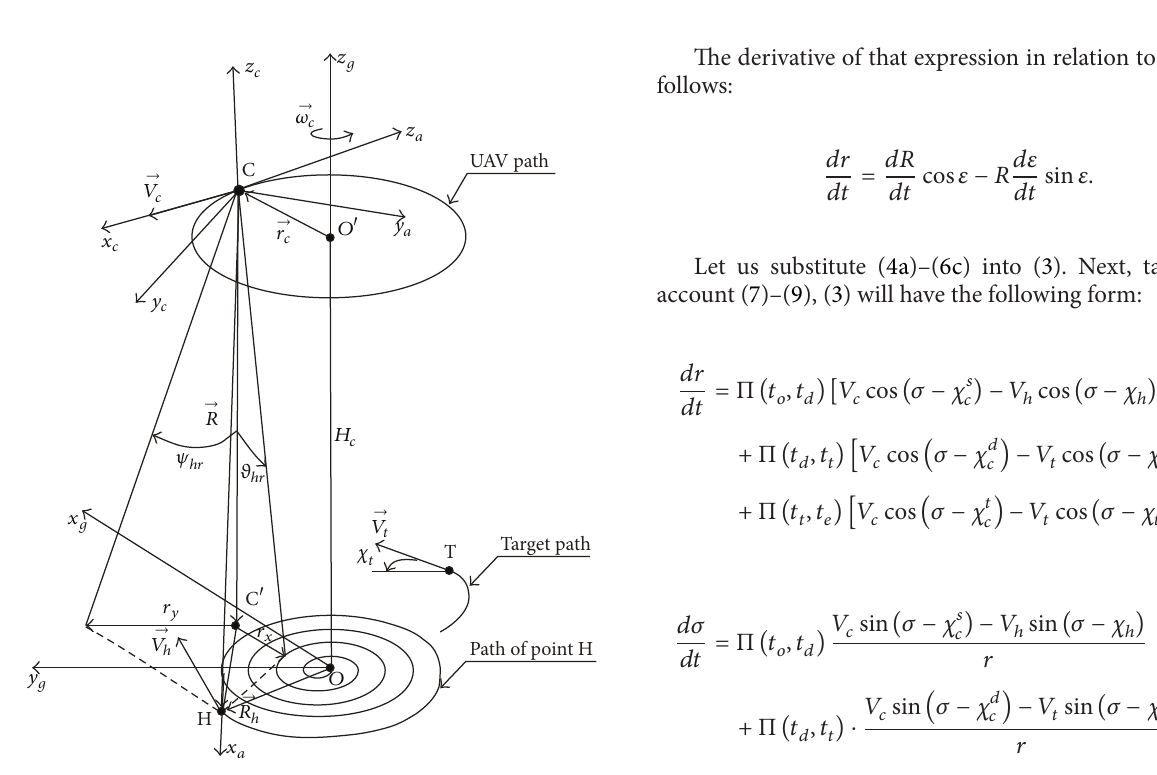
Figure3:KinematicsofmutualmovementoftheheadaxisandUAV during scanning the ground